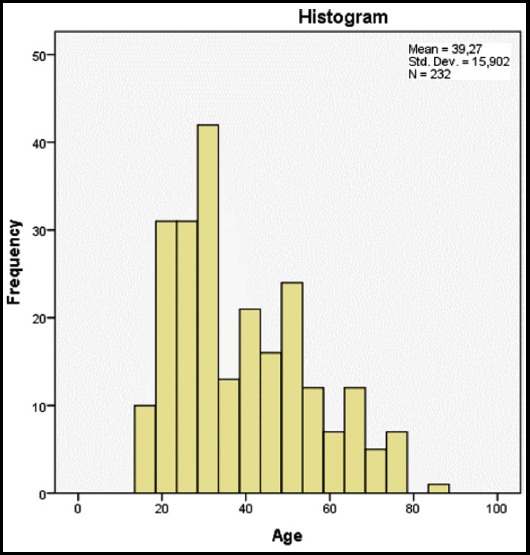
Distribution by age at diagnosis.